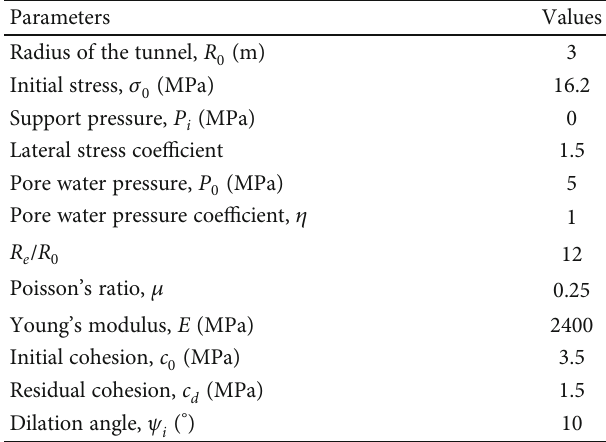
Table 1: Geometrical and mechanical